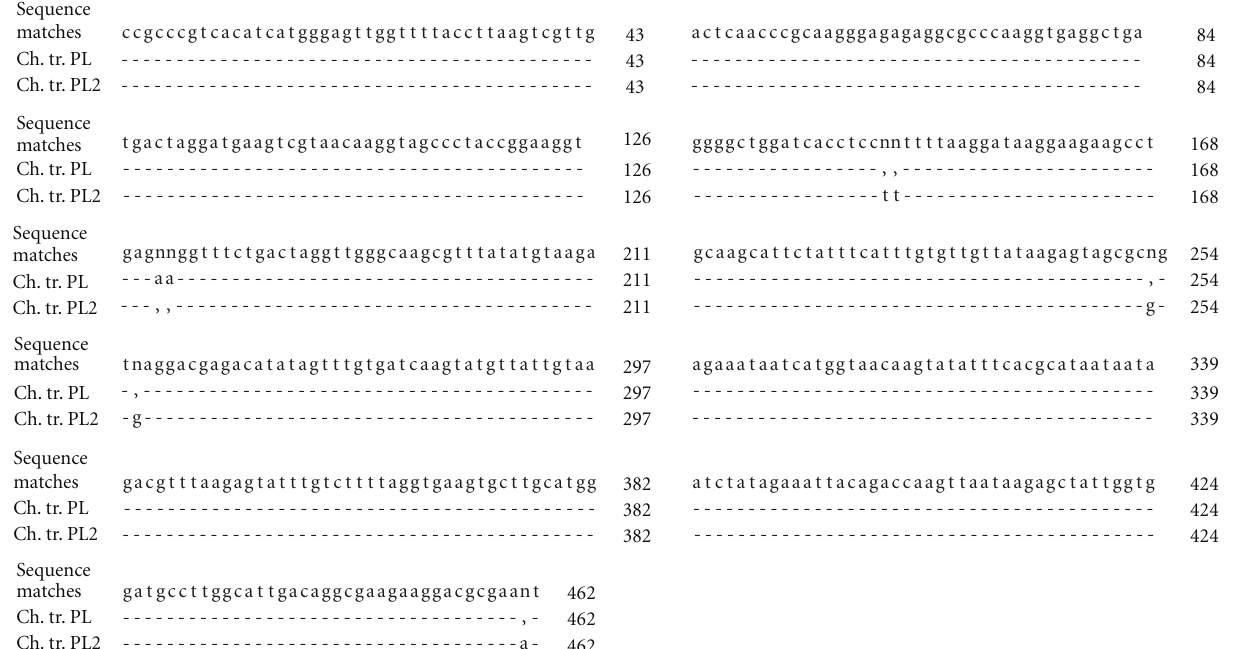
Figure 6: Comparative analysis of 16S–23S nucleotide sequence clusters of the middle ribosomal cluster and 23S rRNA I domain of plasmid Chlamydia trachomatis strains released from monkeys (PL strain) and from humans (PL2 strain). ( - )—match of nucleotides in the sequence, (n)—mismatch of nucleotides in the sequence, (,)—absence of nucleotides in the sequence, (43-462)—nucleotide sequence